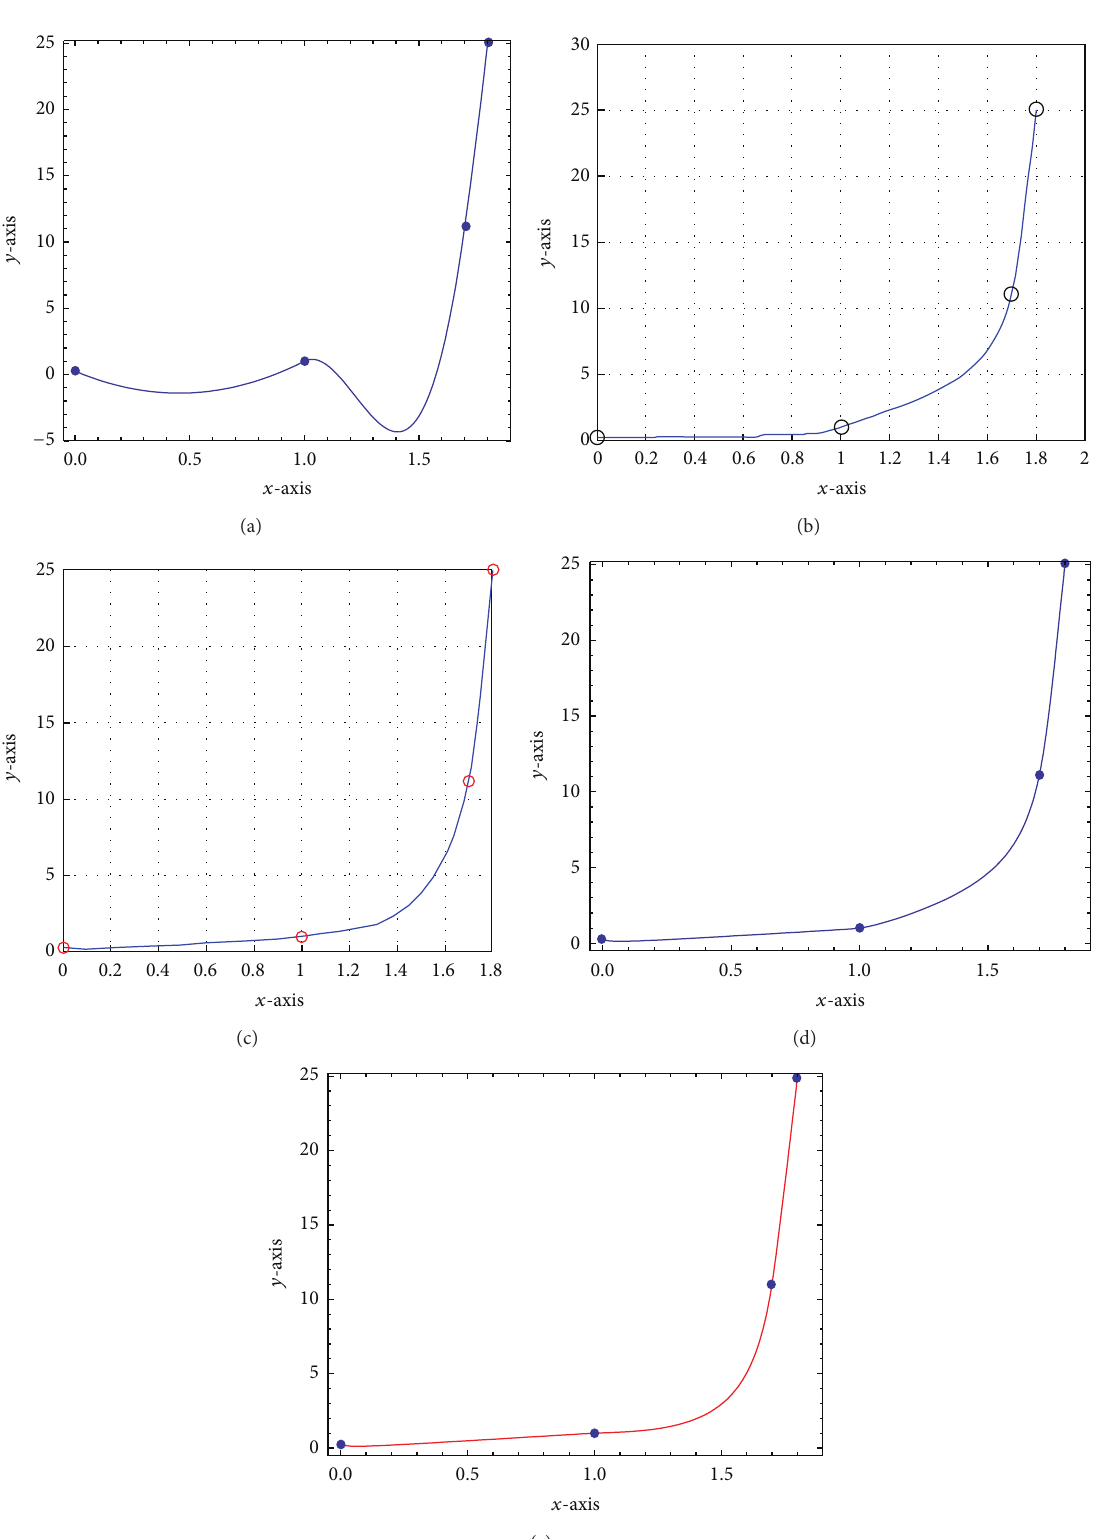
Figure 3: Comparison of (a) cubic Hermite spline curve, (b) Hussain et al. [10], (c) Abbas et al. [12], and positivity-preserving rational cubic spline with values of shape parameters: (d) 𝛼 𝑖 = 𝛽 𝑖 = 0.5 ; (e) 𝛼 𝑖 = 𝛽 𝑖 = 2